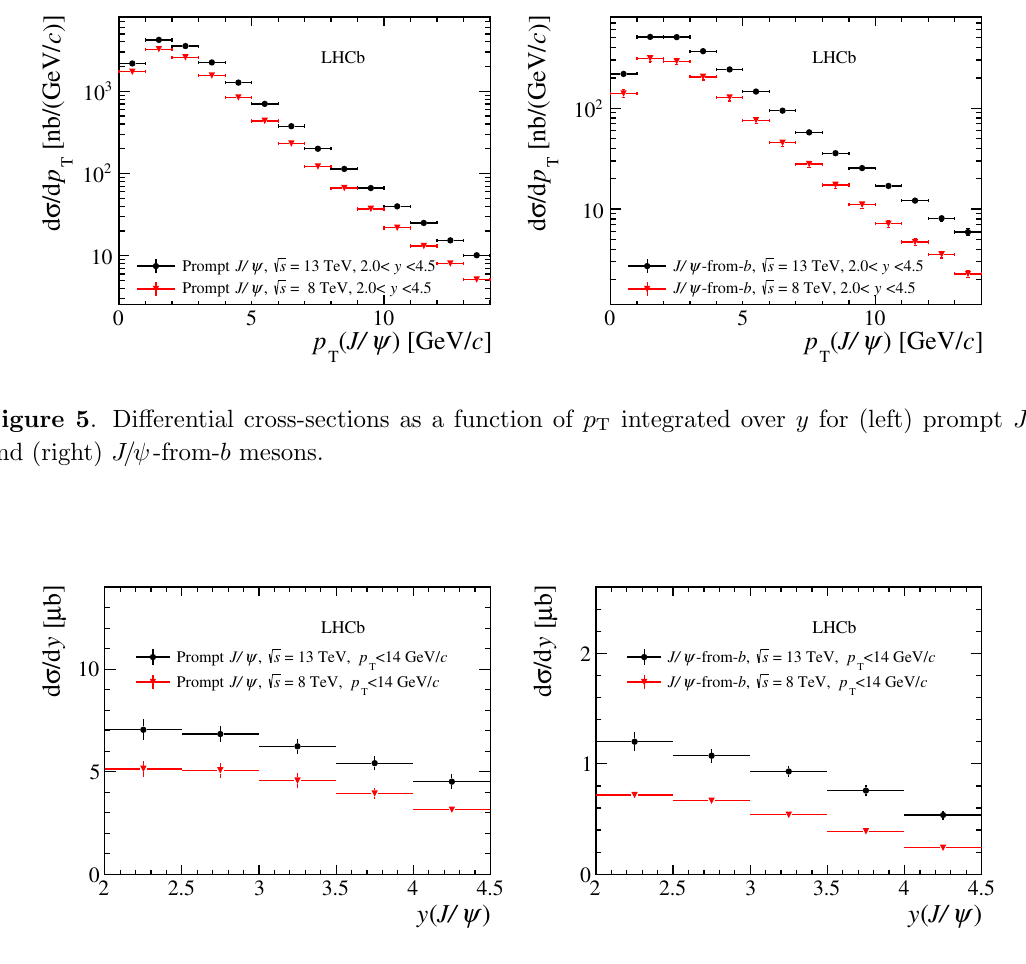
Figure 6 . Di(cid:11)erential cross-sections as a function of y integrated over p T for (left) prompt J= and (right) J= -from- b mesons.